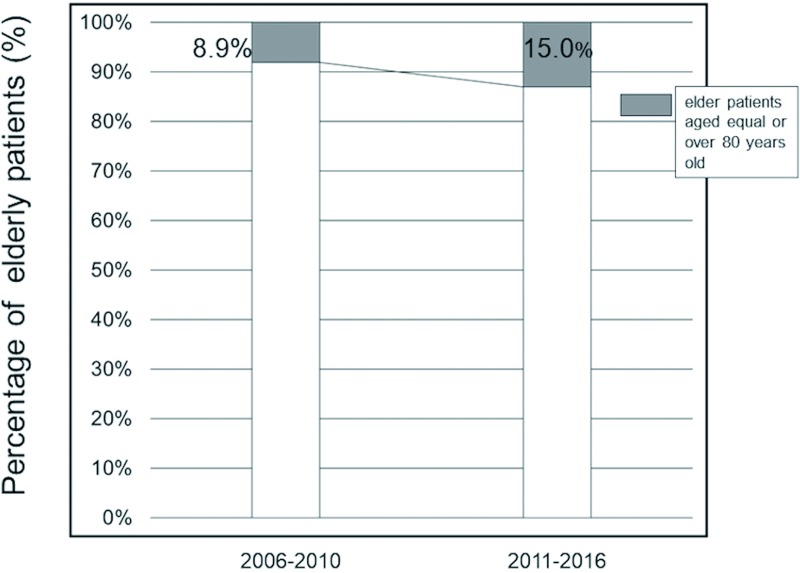
Bar graph showing the percentage of patients in the study aged ≥80 years.